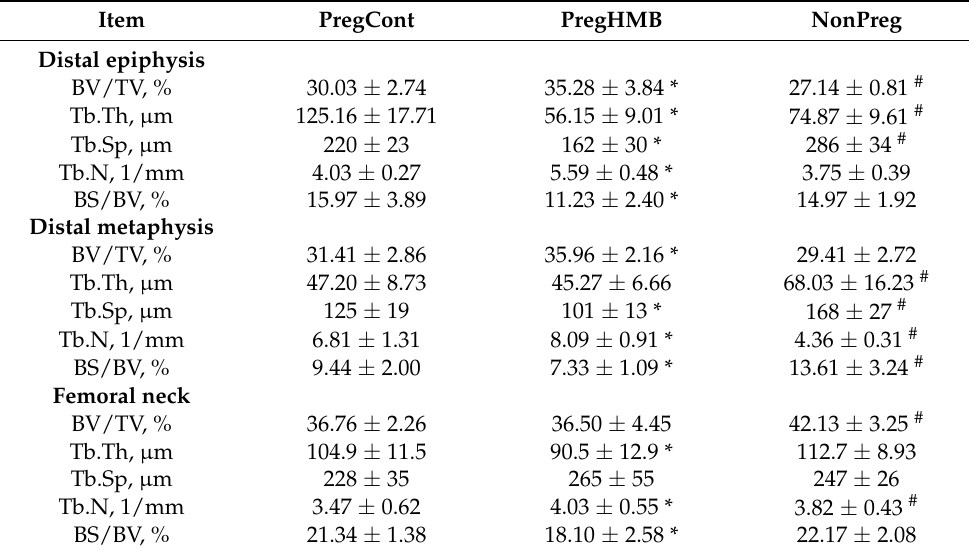
Table 3. Osteometric, mechanical, and densitometric parameters of femora from pregnant (control and supplemented with β -Hydroxy β -methylbutyrate (HMB)) and non-pregnant female spiny mice. Item